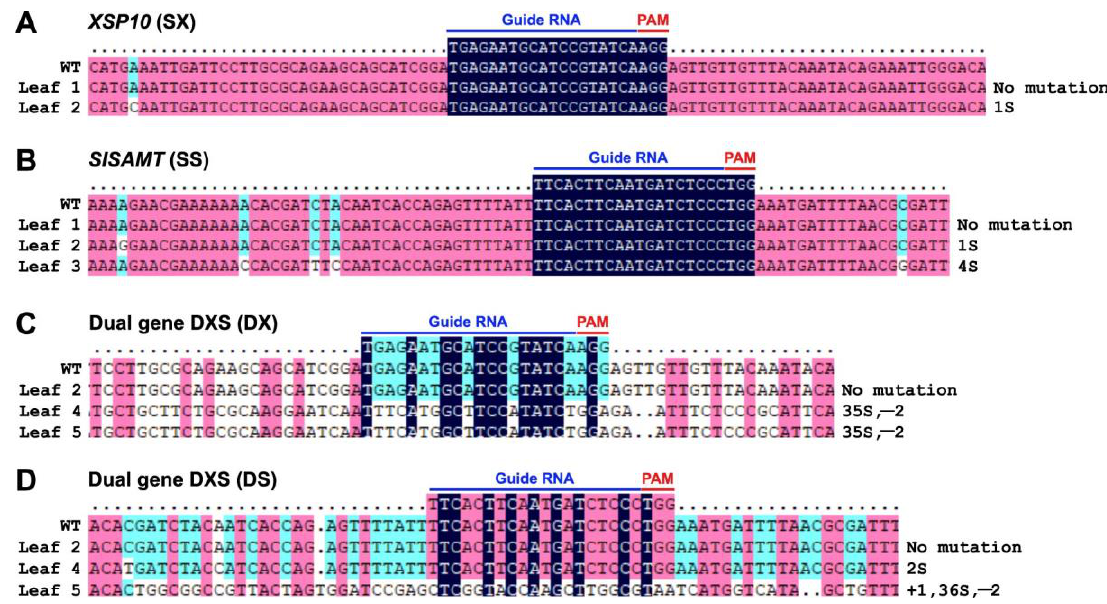
Figure 2. Sanger sequencing confirmation of single and dual-gene DXS CRISPR editing events of Fol 1322 tolerant leaves of tomato. Insertion (+), deletion ( − ), substitution (s). ( A ) Leaf 2 of XSP10 , Leaf 2 and 3 of SlSAMT . ( B ) Leaf 4, 5 of dual-gene editing of XSP10 and SlSAMT . ( C , D ) SX: Single-gene editing of XSP10 , SS: Single-gene editing of SlSAMT , DXS: Dual-gene editing of XSP10 (DX) and SlSAMT